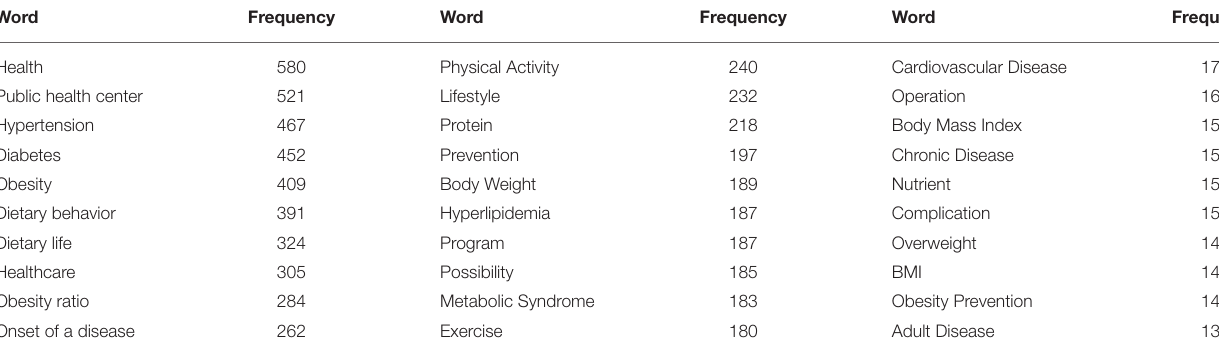
TABLE 4 | Top 30 frequencies before the COVID-19 pandemic.